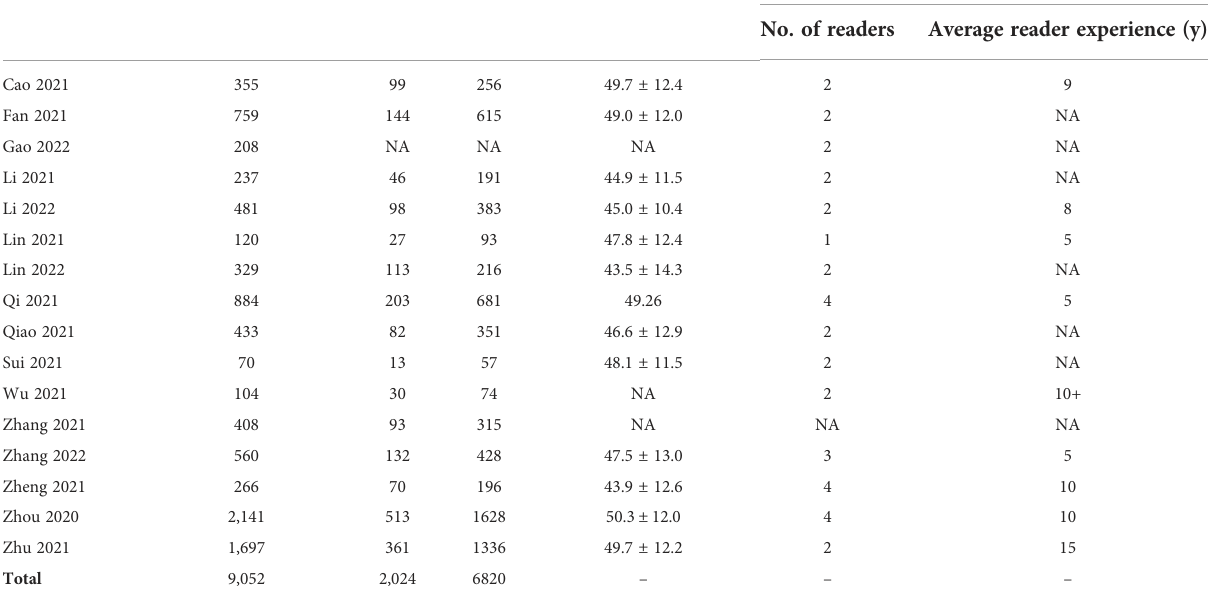
TABLE 2 Baseline characteristics of included